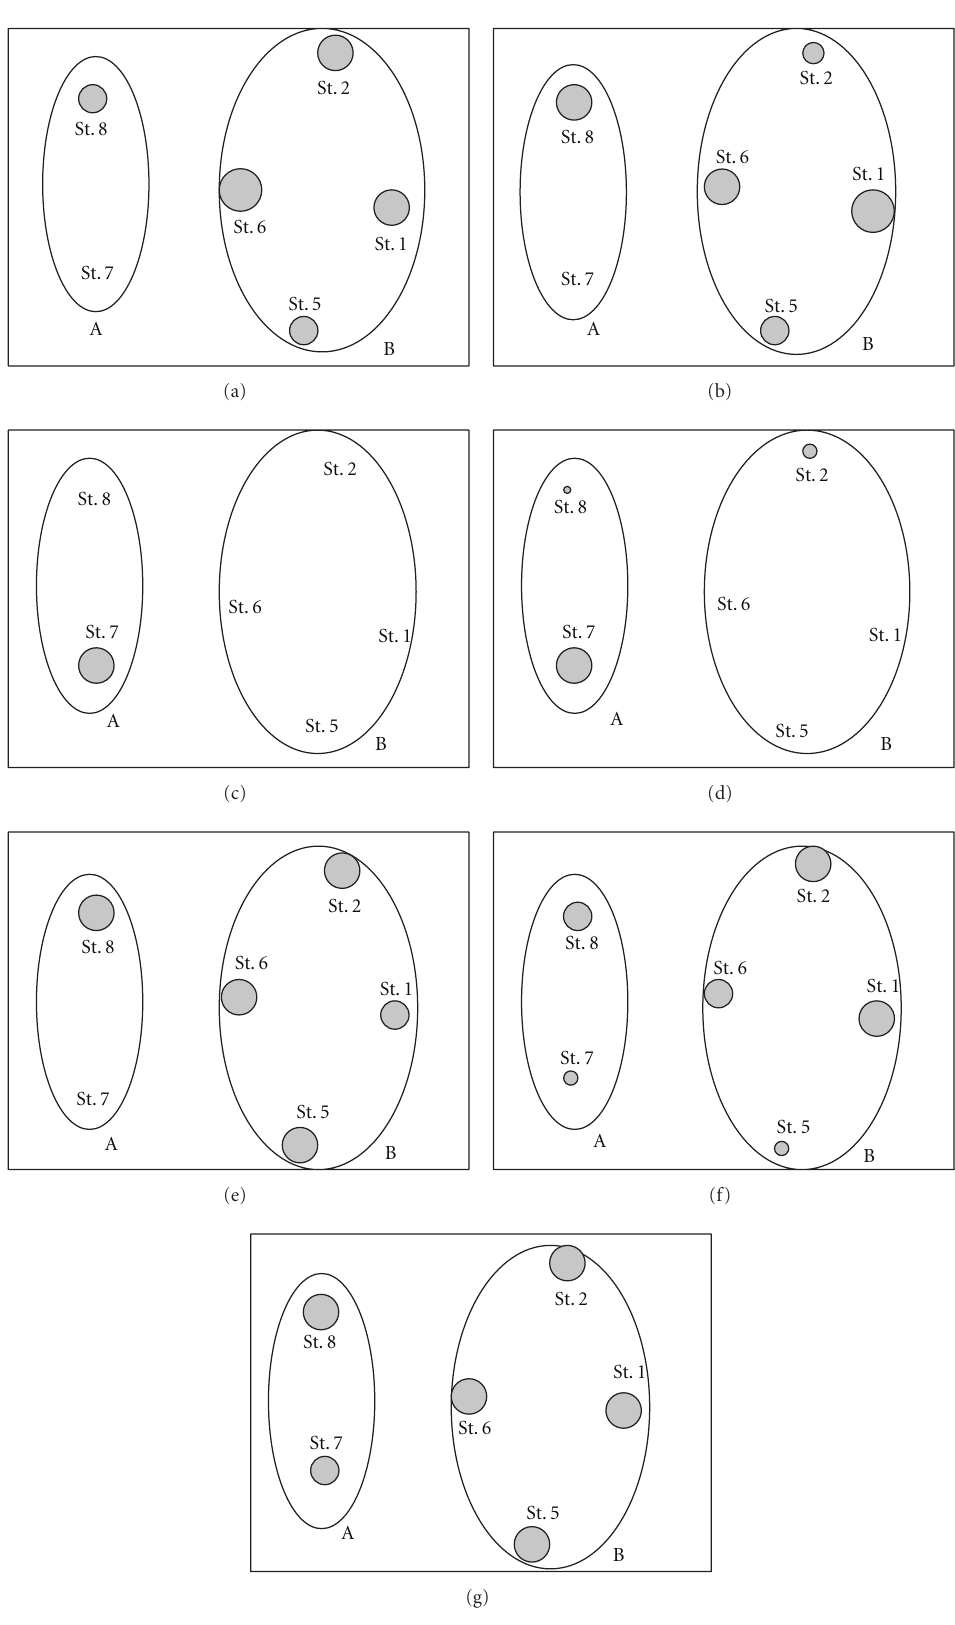
Figure 4: Environmental variables superimposed in each localities on frequency nMDS: (a) gravel, (b) coarse sand, (c) fine sand, (d) slimes and clays, (e) organic matter, (f) selection coe ffi cient, and (g)